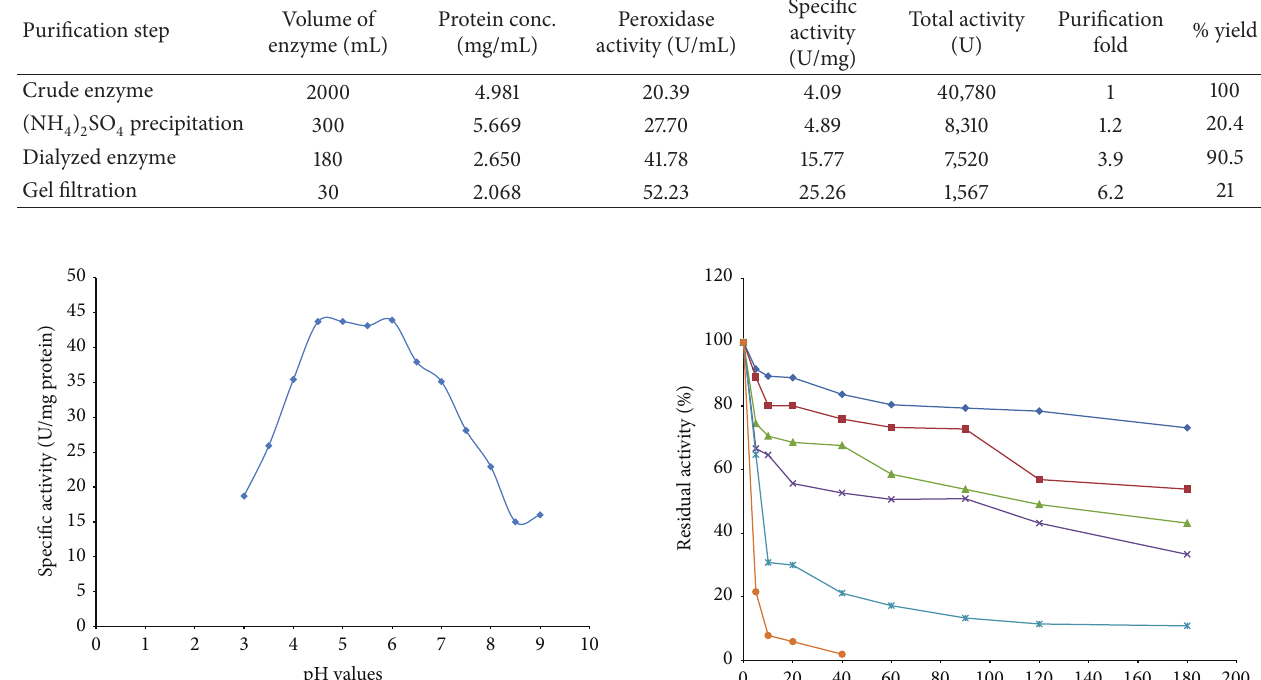
Figure 3: pH stability of garlic peroxidase.